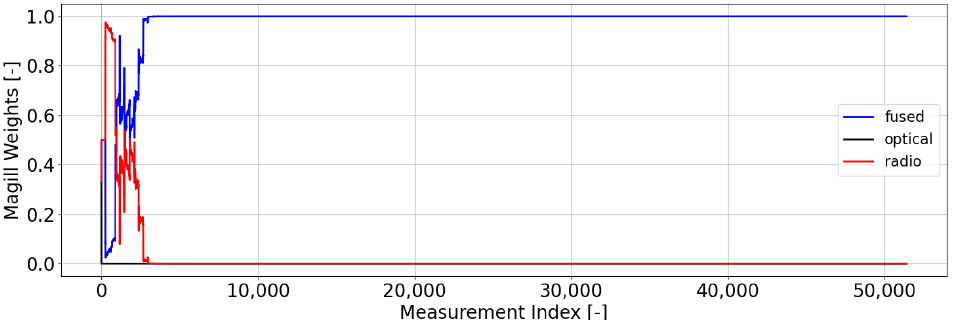
Figure 6. Magill gating network weights with properly modeled